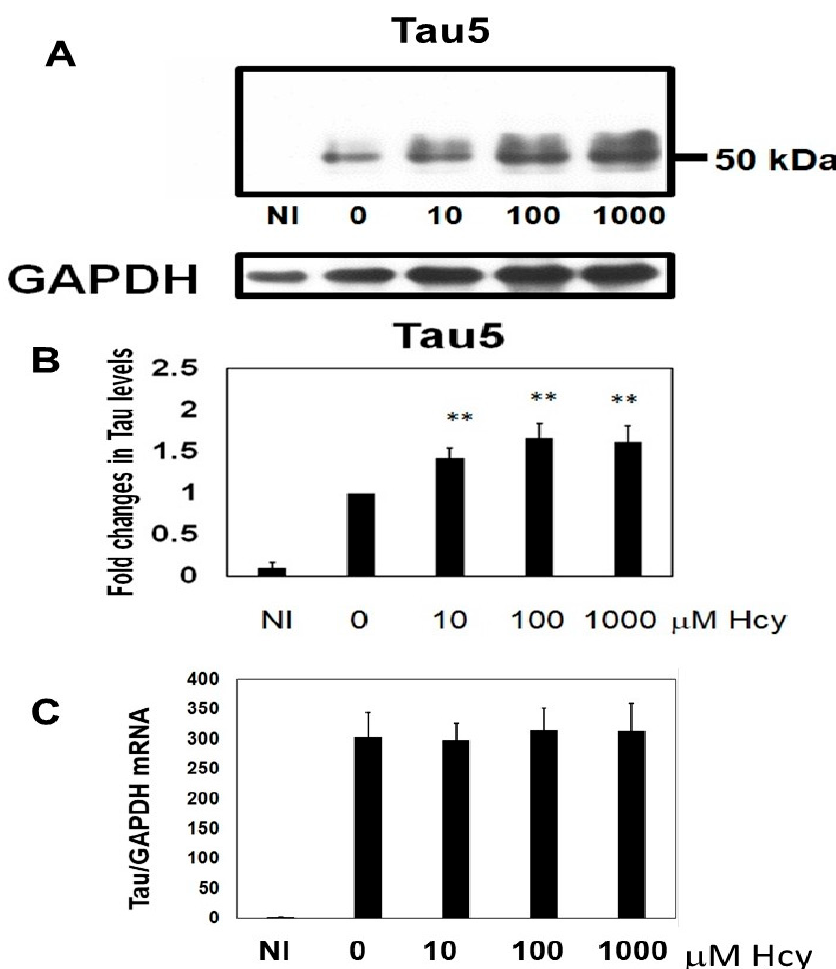
Figure 2. Total tau protein was increased by L-homocysteine (L-Hcy) in M1C cells. M1C cells were subjected to 5 days of tau expression (by reducing tetracycline) and cells were exposed to 10, 100, 1000 µ M L-Hcy during the final 24 h of tau induction. The amount of Tau5 positive tau was increased in a dose-dependent manner when cells were treated with L-Hcy. Glyceraldehyde 3-phosphate dehydrogenase (GAPDH) was used as a loading control. Bar: ± SD, ** p < 0.01 ( A , B ). qPCR showed that mRNA levels of tau did not change with Hcy treatment ( C ). NI: non induced Hcy treatment decreased phosphorylation of Ser9 in GSK3 β , which implies that GSK3 β activity was increased (Figure 4A). Hcy treatment increased phosphorylation levels of cdk5, which implies cdk5 activity was upregulated (Figure 4B). The catalytic subunit of PP2A was examined by anti-demethylated PP2A (DPP2A, labels inactive PP2A) and anti-total PP2A antibody. DPP2A was increased following Hcy treatment, but total PP2A did not change (Figure 4C), suggesting Hcy inactivated PP2A as previously reported